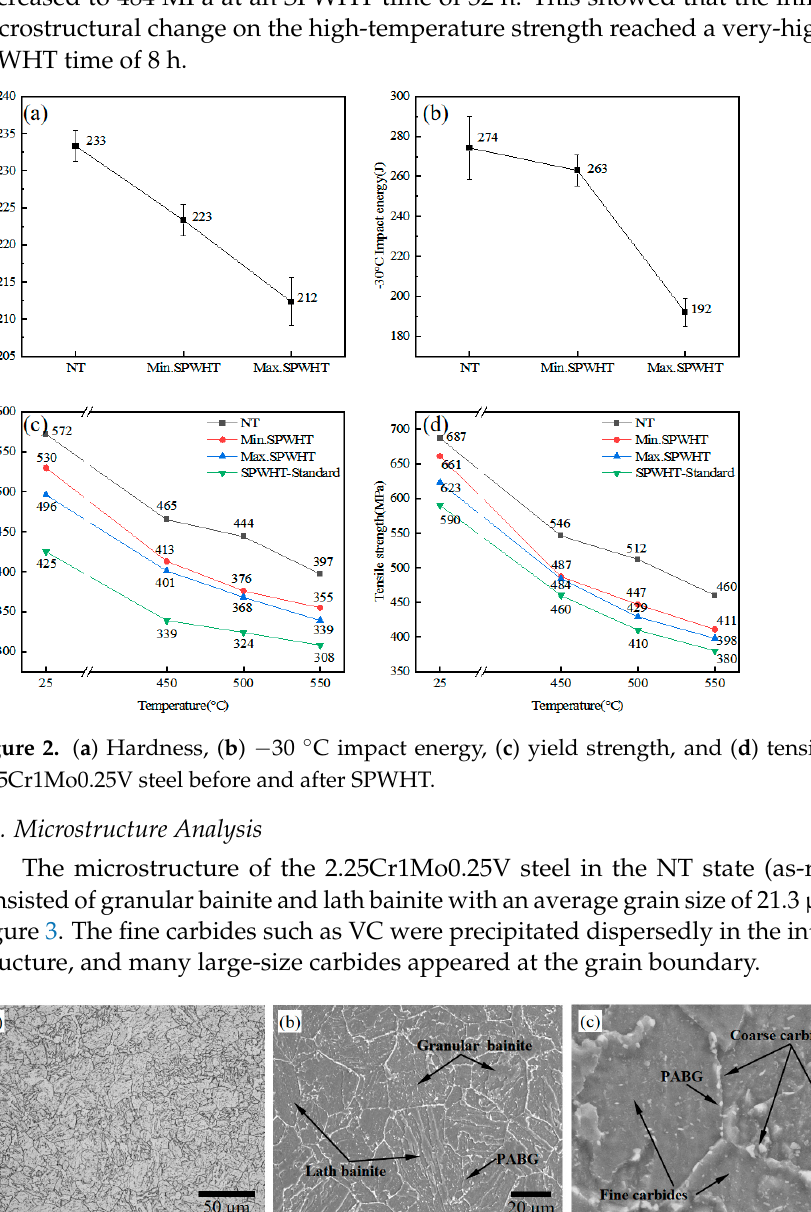
Figure 2. ( a ) Hardness, ( b ) − 30 °C impact energy, ( c ) yield strength, and ( d ) tensile strength of 2.25Cr1Mo0.25V steel before and after